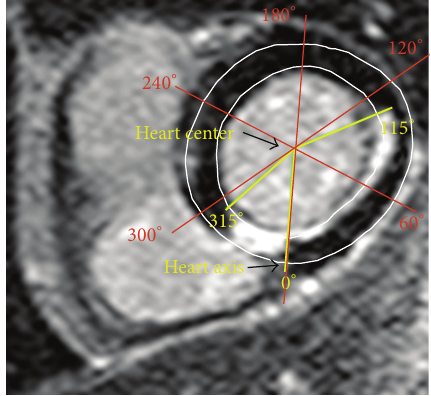
Figure 4: Example of one slice with manual marking. The slice has visual marking of the heart center and the heart axis as the line betweentheheartcenterandthepointwhererightandleftventricles are coinciding. The slice is taken from the basal cavity and the scar is located between 315 ∘ and 115 ∘ . The location of the scar according to the 17-AHA is for segment 3 scars between 300 ∘ and 360 ∘ , for segment 4 between 0 ∘ and 60 ∘ , and for segment 5 between 60 ∘ and 120 ∘ . In this example, the part of segment 3 is 360 ∘ − 315 ∘ = 45 ∘ , segment 4 is 60 ∘ , and segment 5 is 115 ∘ − 60 ∘ = 55 ∘